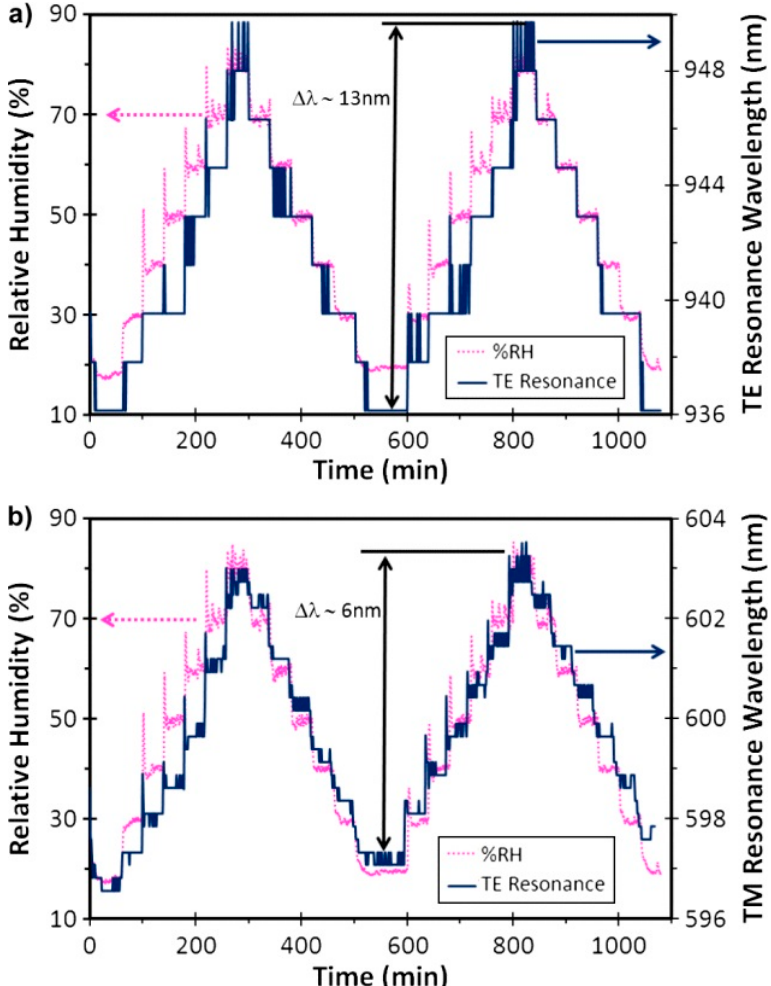
Figure 9. Relative humidity sensitivity test preformed for a In 2 O 3 -based sensor. The curve obtained from the LMR probe closely follows the one provided by the electronic RH sensor in both TE (a) and TM (b) modes. Reprinted from [39] with permission from IEEE.